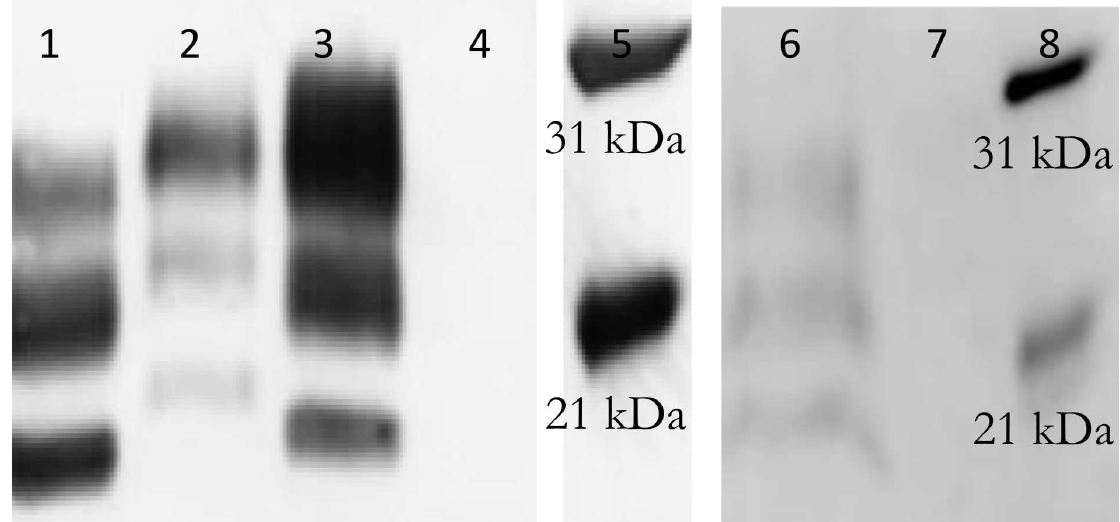
Fig 1. Western blot of a representative brain sample of each BSE strain and TME in cattle. Brainstem sampleswere characterized by western blotting(mAb 6H4). Lanesfrom left: 1. French L-type (#6895, 2 mg);; 2. U.S. H-type (#80, 2 mg); 3. Classical(#6836,1 mg); 4.NegativeControl(#6969, 2 mg); 5. Biotinylatedprotein marker; 6. BovineTME (Animal #52AA, 2 mg); 7. NegativeControl(#6969, 2mg); 8. Biotinylatedprotein